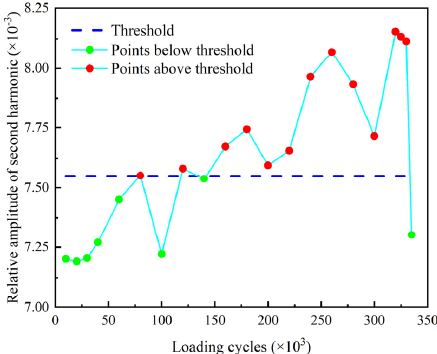
Figure 29. Relative amplitude of second harmonic 𝛽 (cid:3045)(cid:3032)(cid:4593) versus loading cycles